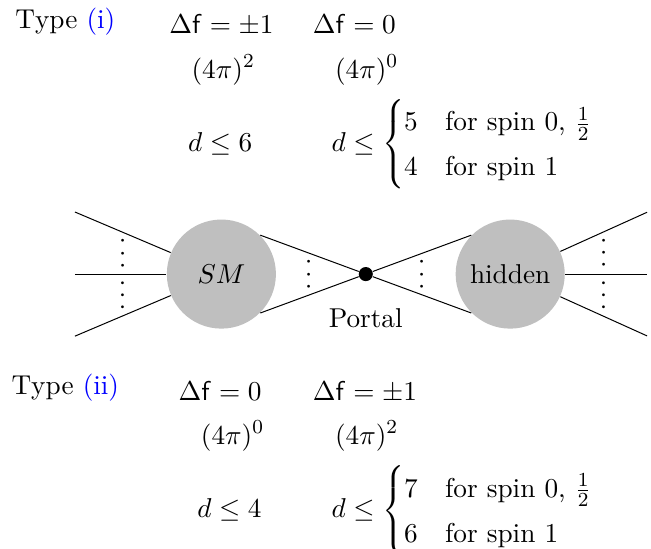
Figure 6. Schematic representation of the two possible types of quark-flavour violating diagrams at the strong scale, which we distinguish based on the sector in which the flavour violation is located. We assume that the relevant strong scale PET is the low energy limit of a corresponding EW scale portal SMEFT. The diagrams show the suppression due to NDA power counting and the dimension of the operators in the diagram. Type (i) diagrams contain a flavour violating SM sub-diagram that scales as (4 π ) 2 and contains one d ≤ 6 Fermi theory operator, as well as one flavour conserving portal operator that scales as (4 π ) 0 and has d ≤ 5 . Type (ii) diagrams contain a flavour conserving SM sub-diagram that scales as (4 π ) 0 and contains only renormaliseable d ≤ 4 operators, as well as one flavour violating portal operators that scales as (4 π ) 2 and have d = 6 , 7 or 5 , 6 . Type (i) diagrams with d = 5 portal operators and type (ii) diagrams with d = 7 portal operators can appear in strong scale PETs with spin 1 messengers that are derived from other EW scale PETs besides portal SMEFT. See also appendix A.1 and [175–178] for details on the NDA